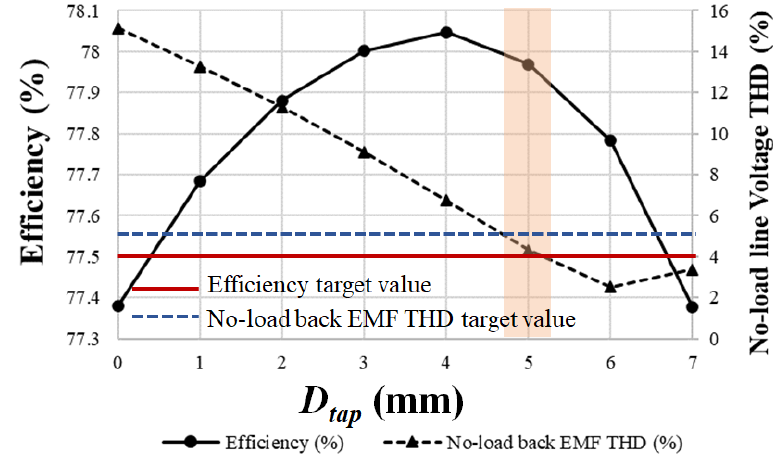
Figure 16. Efficiency and no-load line voltage total harmonic distortion (THD) with D tap (4000 rpm).